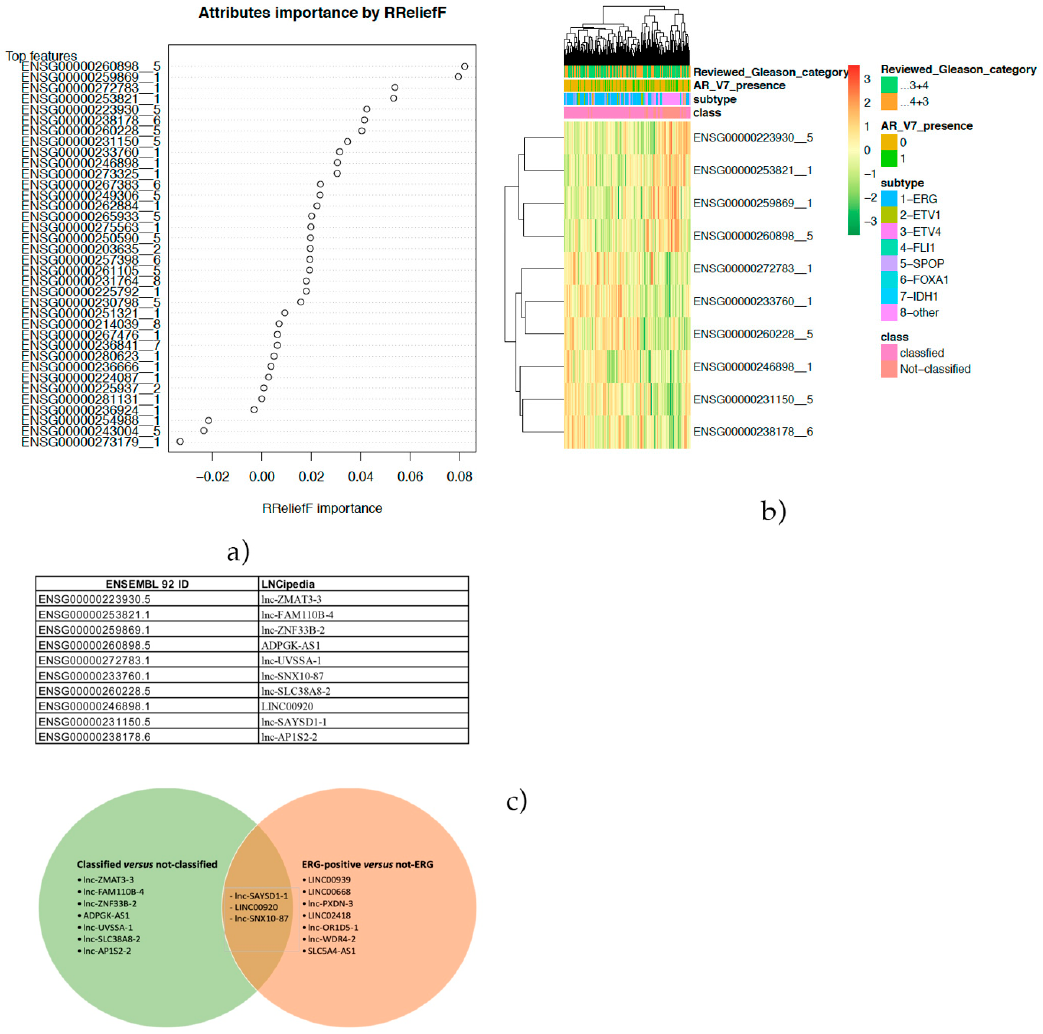
Figure 7. ( a ) Dot plot representing lncRNAs ranked by their importance. ( b ) Cluster gram of the best top 10 lncRNAs discriminated by classified/not-classified prostate cancer (PCa) cases. ( c ) Ensembl ID/LNCipedia ID conversion table and Venn diagram including top 10 ERG/not-ERG lncRNAs and classified/not-classified lncRNAs.